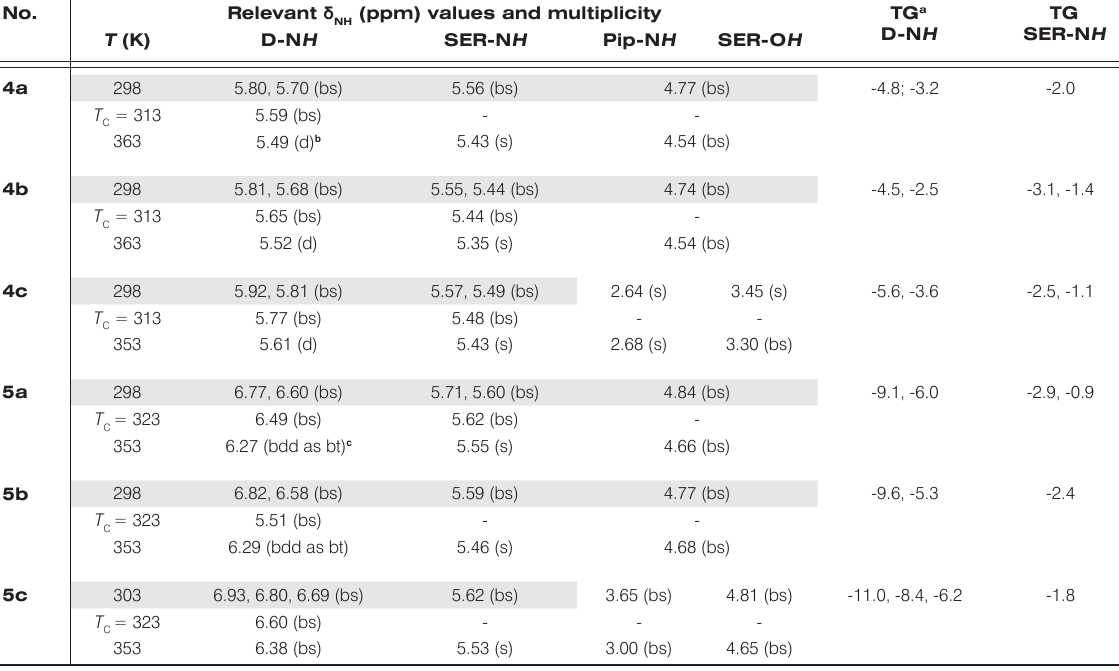
Table 6. Relevant (VT) 1 H NMR data and Temperature Gradients of melamines 4a-c and 5a-c (on 500 MHz timescale in [D